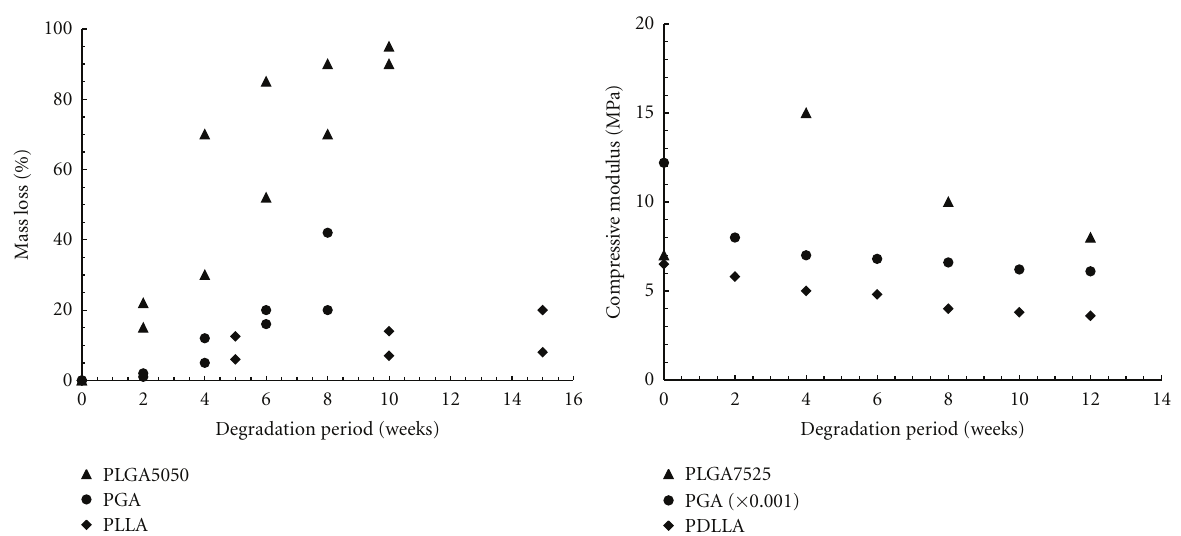
Figure 1: Mass loss and strength retention of some polymers used for sca ff olds. Data compiled from